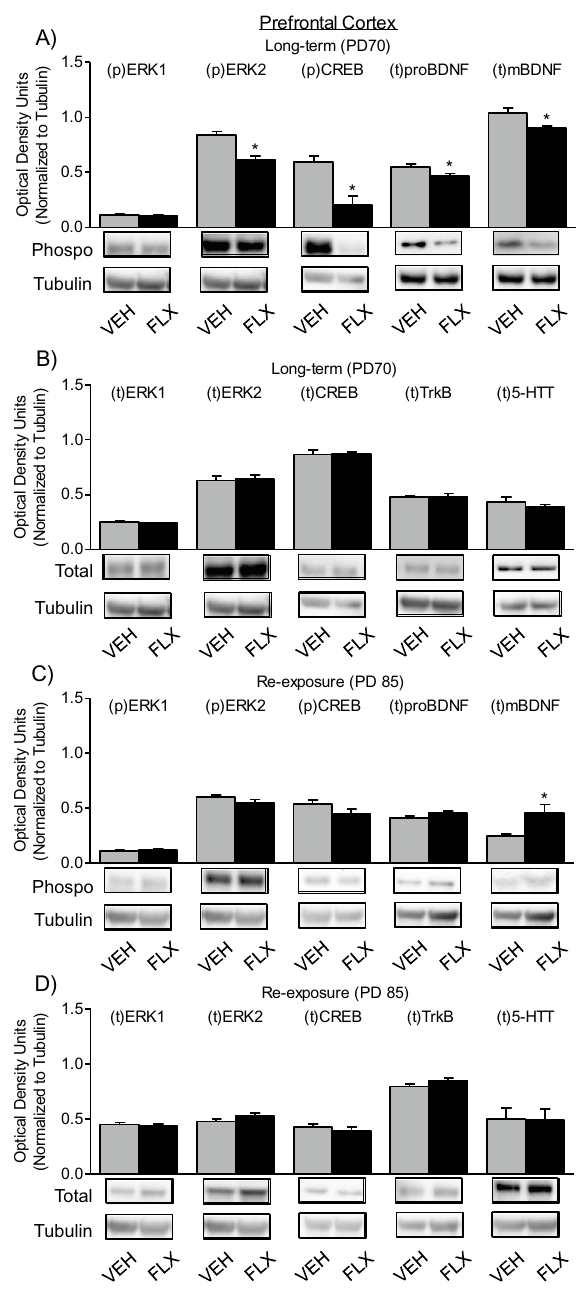
Figure 6. Long-term effects of juvenile FLX treatment, and its re-exposure in adulthood, on ERK1/2, CREB, BDNF TrkB, and 5-HTT proteins in the prefrontal cortex of female C57BL/6 mice. ( A ) Adolescent FLX pretreatment (PD35-49) resulted in significant decreases in phosphorylated (p) ERK2, (p)CREB, (t)proBDNF, and (t)mBDNF at PD70 (Long-term), when compared to water (VEH)-treated controls ( B ) No significant differences in total protein levels of ERK1/2, CREB, TrkB were apparent 21-days after juvenile FLX treatment. ( C ) Re-exposure to FLX in adulthood (PD70-84) normalized (p)ERK, (p)CREB, and (t)proBDNF, and significantly increased (t)mBDNF, 24 h after the end of antidepressant re-exposure (PD85). ( D ) No differences in (t)ERK1/2, (t)CREB, (t)TrkB, or (t)5-HTT were observed on PD85, as a function of juvenile FLX exposure (PD35-49) and re-exposure in adulthood (PD70-84). Western blots of prefrontal cortex tissue, with α-Tubulin as loading control, were performed under identical protocols. Representative images were cropped from different blots (Supplemental Figure S2). Data are presented as mean ± SEM. * p <